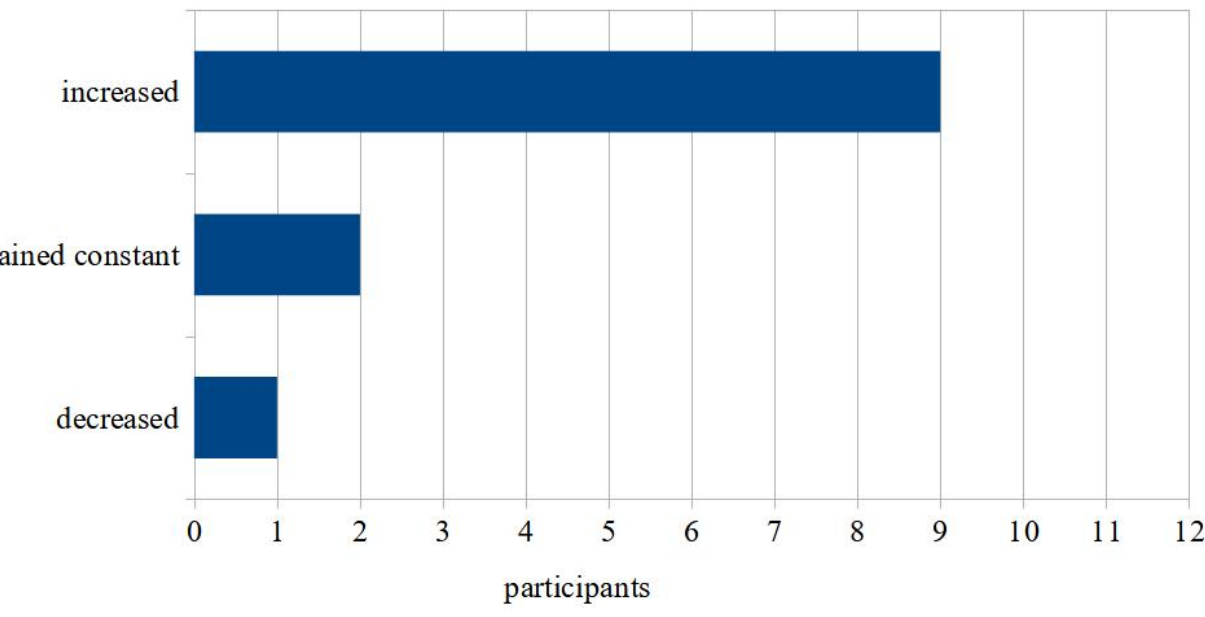
Figure 3. Evaluation of the statements within a single choice for the following statement: “My interest in remote treatments is due to patient discussions …” .